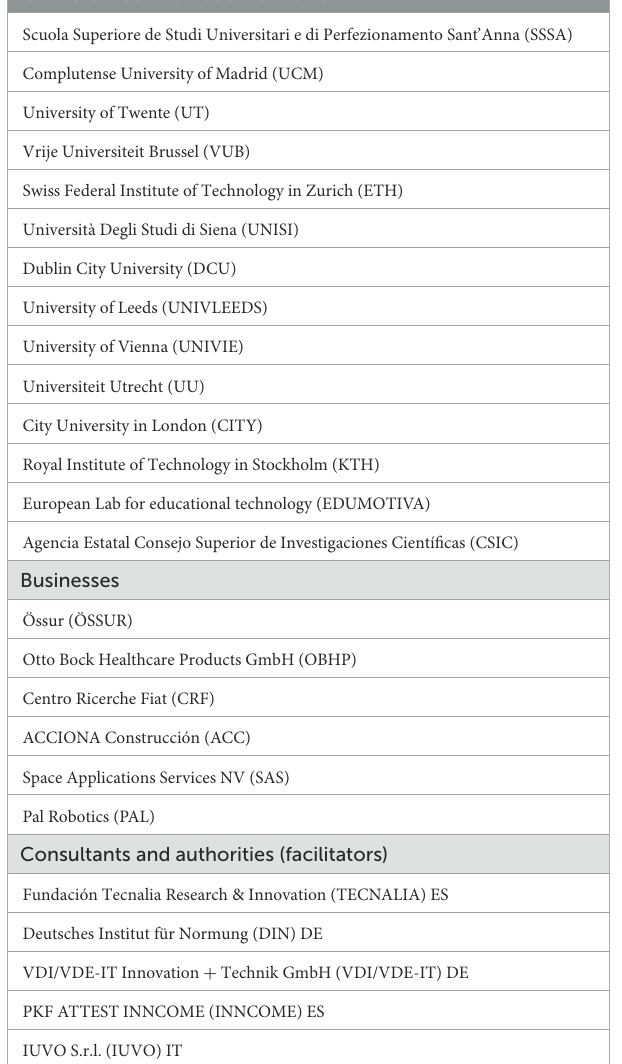
TABLE 1 List of the stakeholders that collaborated in collecting